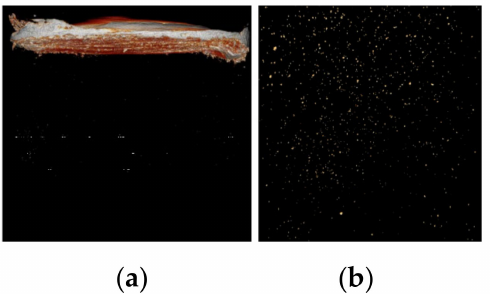
Figure 22. Images of the difference mapping method used for 2D renderings of 3D information —( a ) filter encrust deposited with random alteration within few about 1 mm deep into the rock material ( b ) permeation of RDF into micropore structural network